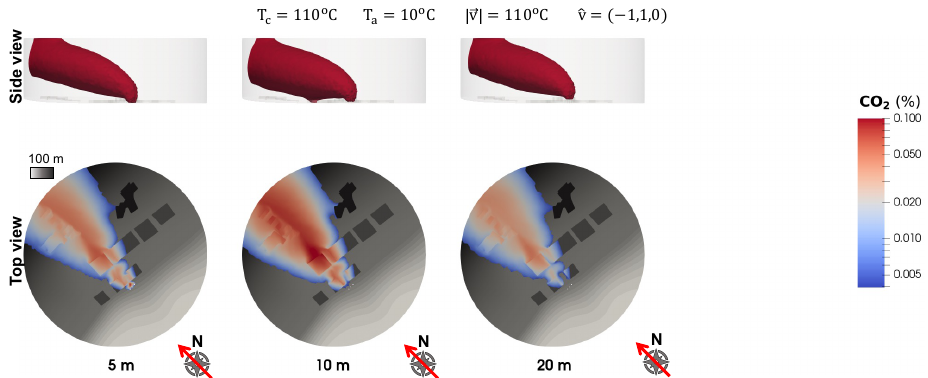
Figure 7. Chimney height. Concentration of CO 2 at ground level for wind speed u = 5 m/s and north-west ( − 1,1, 0 ) direction. The ambient temperature is 10 ◦ C and the exhaust gas temperature 110 ◦ C in all cases. The terrain height is represented in a grayscale. Lighter colors correspond to lower heights and the sea has the lightest color. The chimneys are three white spots near the coastline. The upper panels show the concentration of CO 2 within the plume. The 0.1%, 1000 ppm, surface for CO 2 was plotted in all